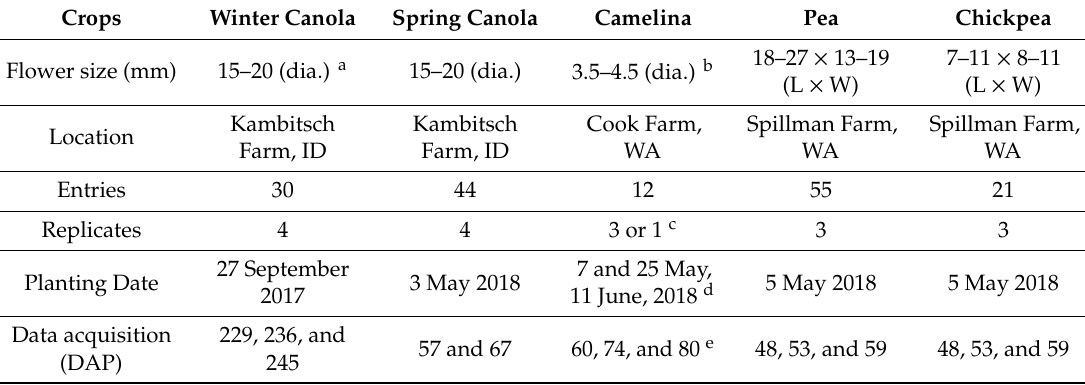
Table 1. Summary of experiments for four cool-season crops in breeding programs. Crops Winter Canola Spring Canola Camelina Pea